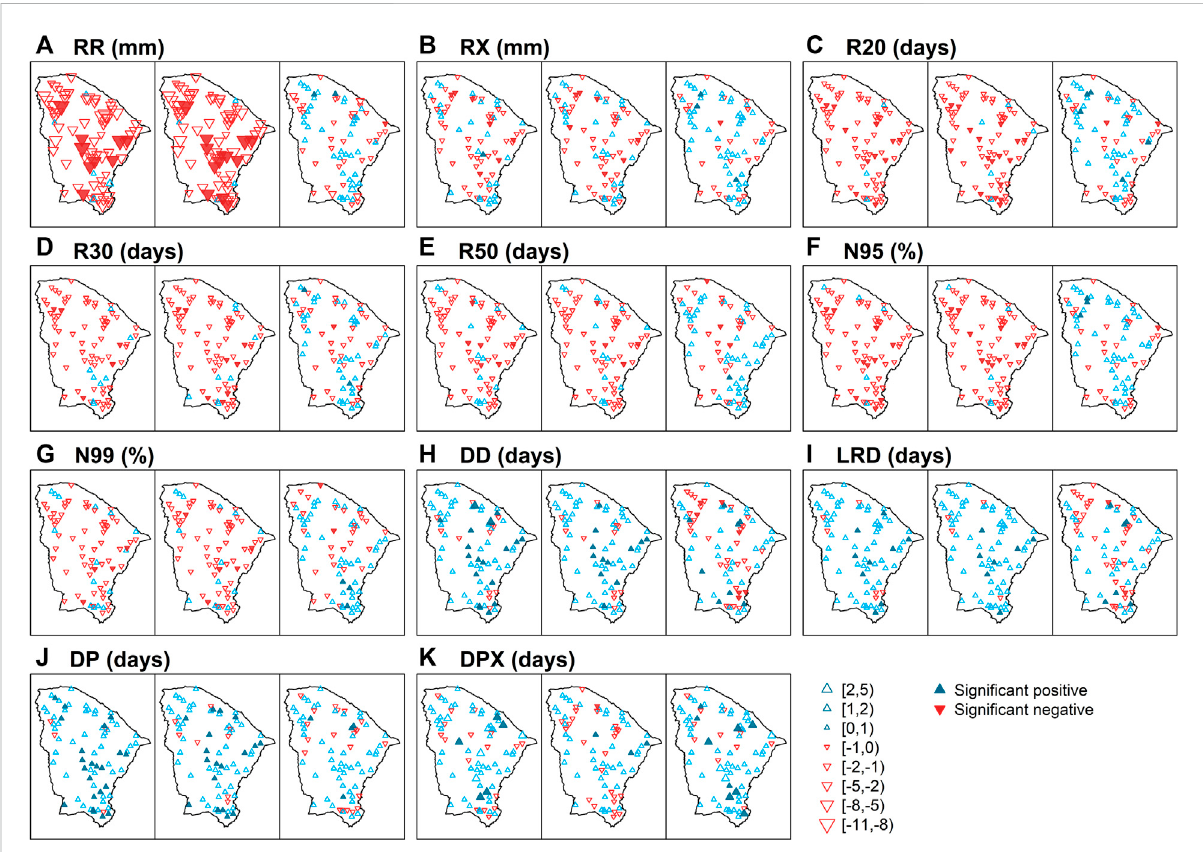
FIGURE 7 Spatial distributionrelated to (A) RR, (B) RX, (C) R20, (D) R30, (E) R50, (F) N95, (G) N99, (H) DD, (I) LRD, (J) DP and (K) DPX of target stations with theincreasing(blue),decreasing (red)ofthetrendsbytheMann-KendalltestandmagnitudebytheSentestduringtheannualperiod(AN-left),rainy season (RS - center) and dry season (DS - right) from 1974 to 2018. Full triangles correspond to trends with statistical signi fi cance at the 5%